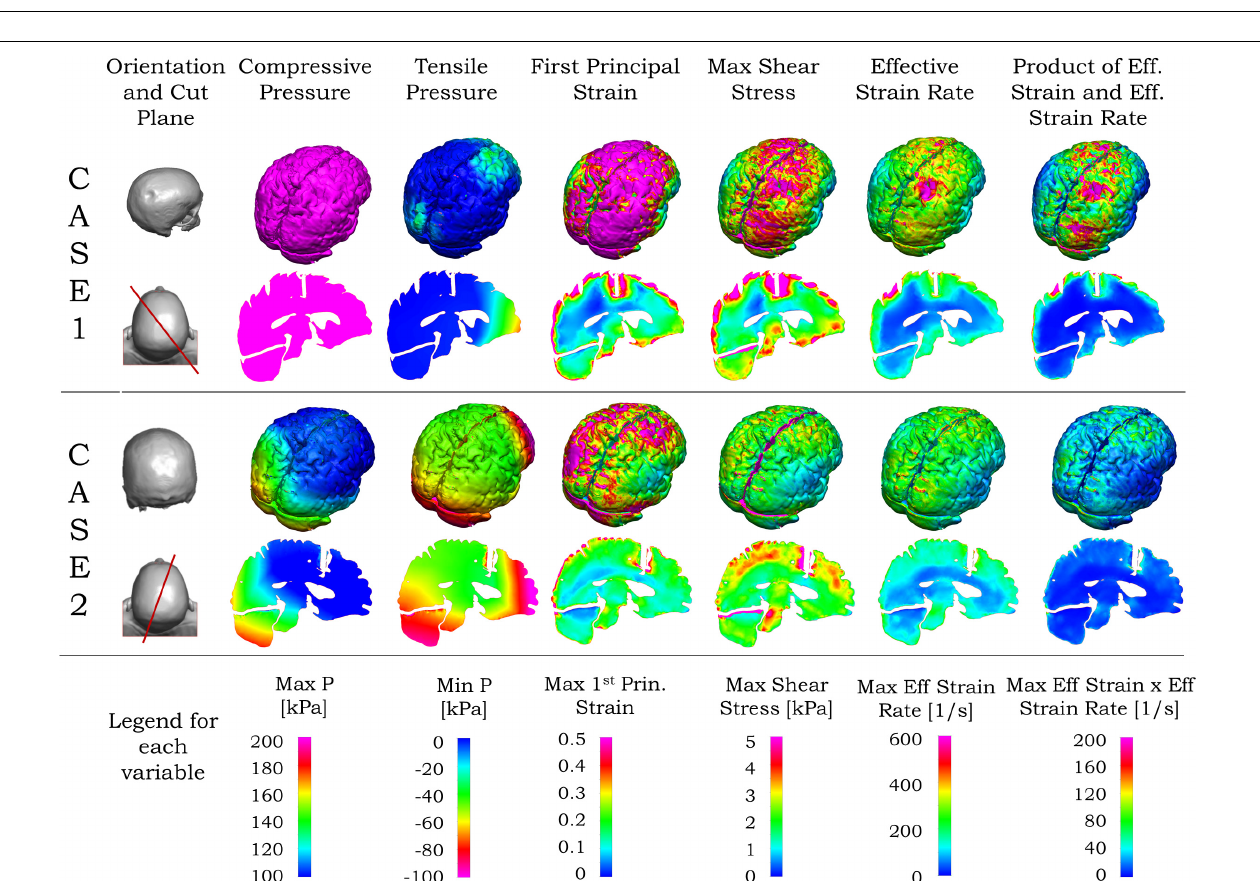
FIGURE 7 | Simulated blunt impact biomechanical responses for cases 1 and 2. For both cases, the second column from left shows the head (top), and vertical plane through the coup–contrecoup line (bottom). For each case, the upper row shows the biomechanical contours for the brain, and the bottom row the contours on the vertical plane passing through the coup–contrecoup line. The last row shows the legends for the maximum of each biomechanical variable specified on the top row. Only data for cerebrum, cerebellum, and brainstem regions are shown.